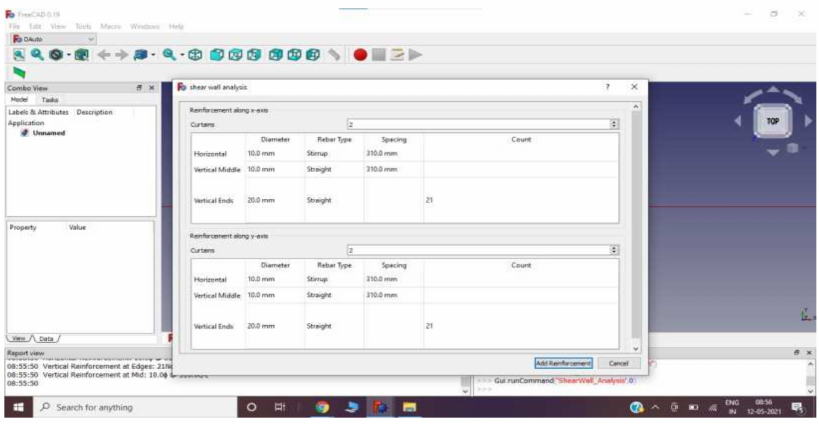
Figure 12. Shear wall design reinforcement.